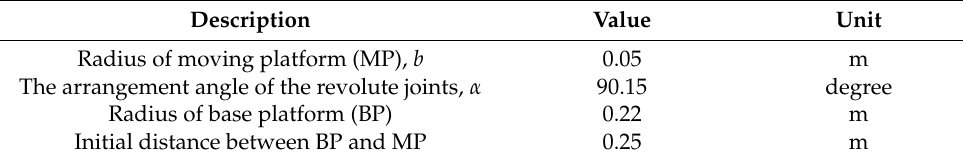
Table 3. The structural parameters of the 3-RPS robot.